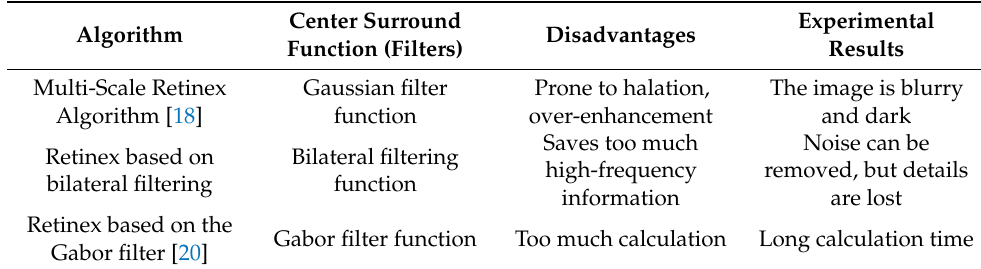
Table 1. Comparison of different improved Retinex